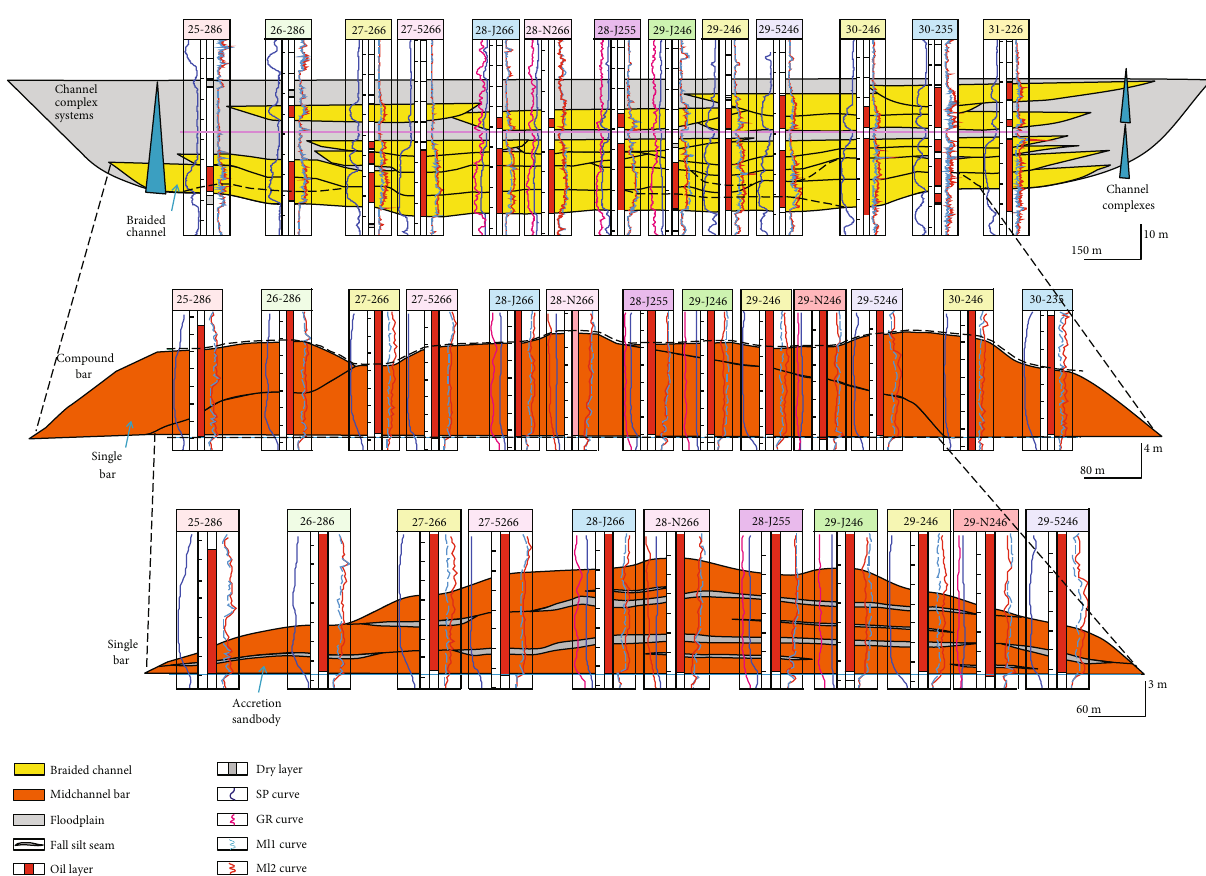
Figure 10: Identi fi cation pro fi les of di ff erent orders of architectural